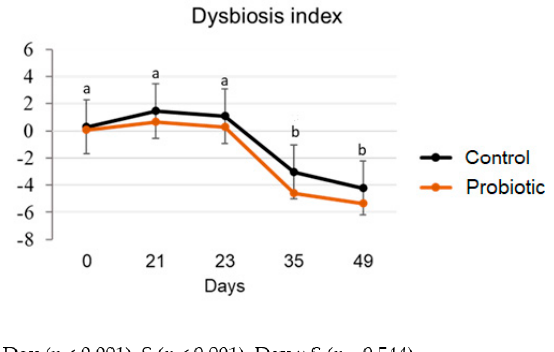
Figure 2. Dysbiosis index of dogs fed a lower protein and fiber diet (day 21) transitioned to a higher protein and fiber diet (days 23 to 49) without (control) or with (probiotic) yeast supplementation (S). a,b Different superscript letters indicate differences among days by the LSD Bonferroni test ( p < 0.05) for both control and probiotic groups.